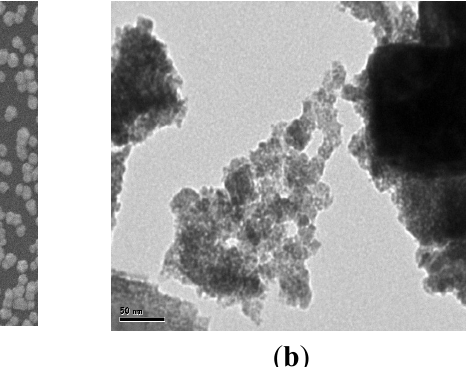
Figure 7. Surface morphology of (Bi